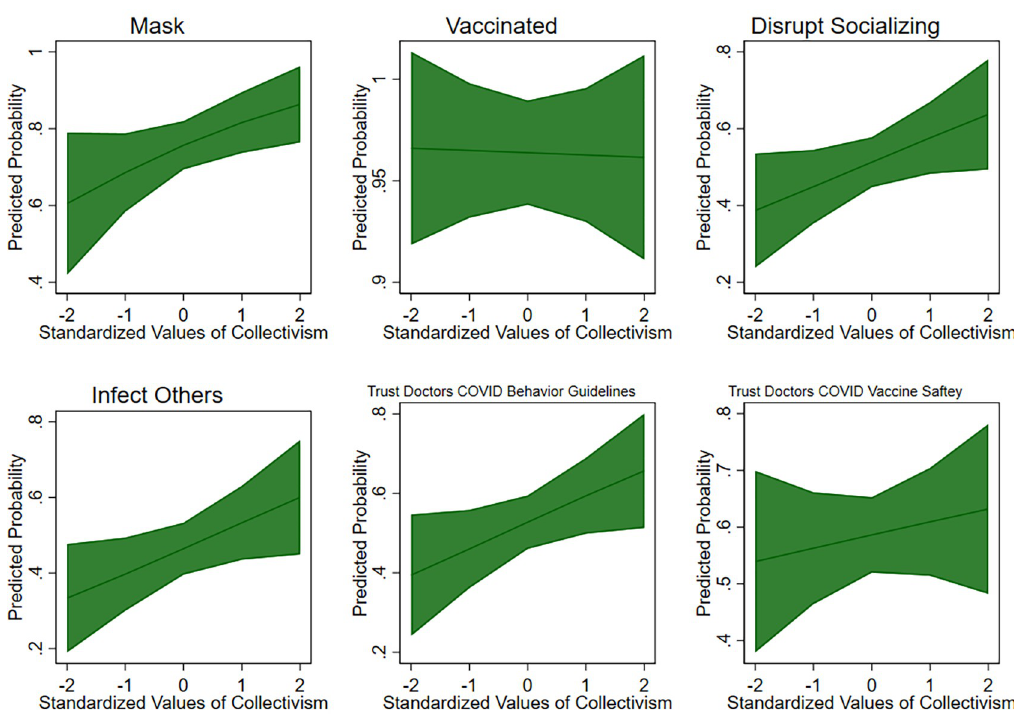
Fig 2. Collectivism and COVID-19 safety behaviors. Fig 2 shows the predicted probabilities (calculated based on Model 3 in Tables 3 and 4) of a variety of COVID-19 behaviors and beliefs as a function of collectivism, while holding age, gender, high risk status and political affiliation constant at their means. The figures demonstrate that higher collectivism is associated with higher probabilities of all of the COVID-19 safe behaviors and beliefs except being